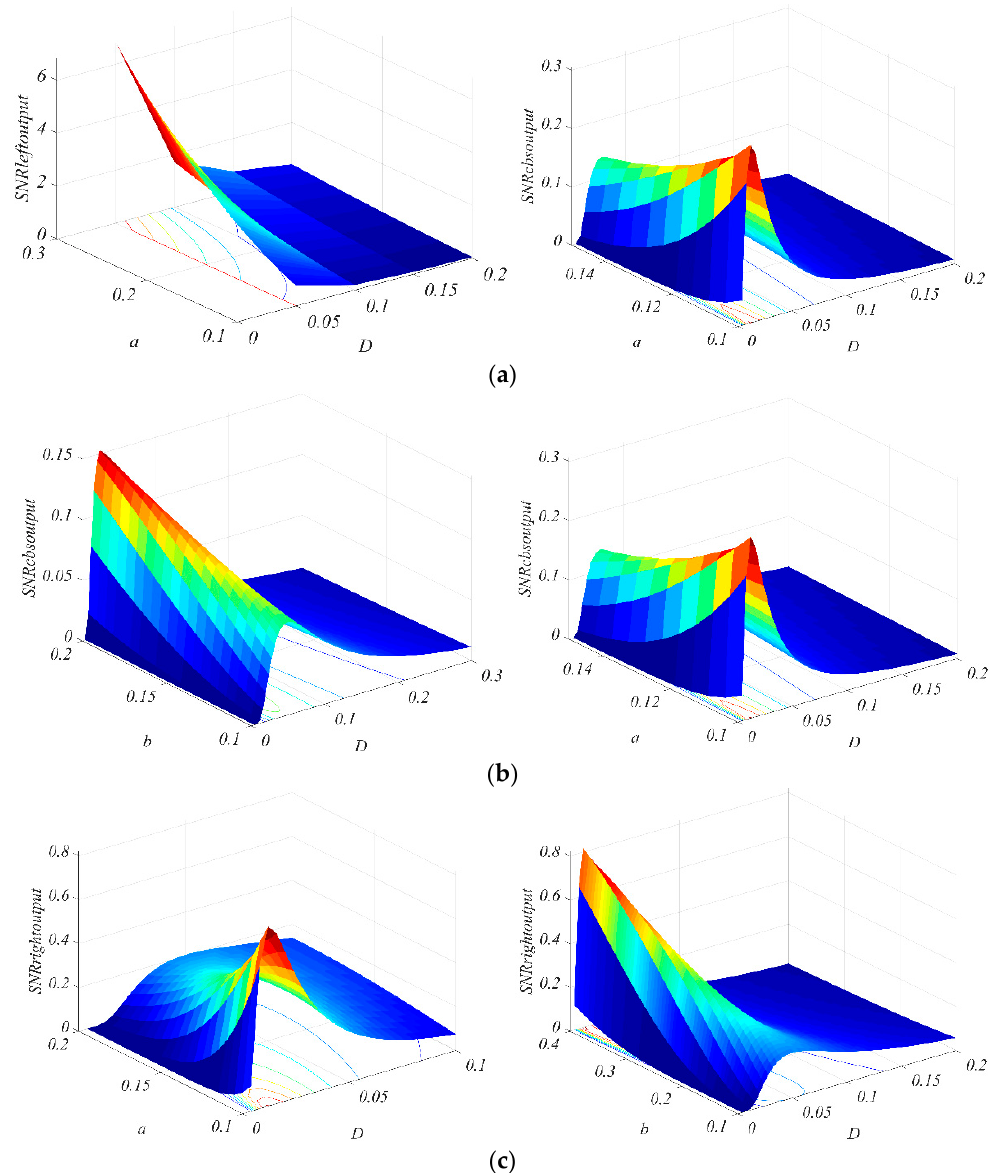
Figure 6. SNR PNABSR changes with parameter a , b , and D . ( a ) The signal-to-noise ratio output of the left well:, b = 0.1, a = 0.1; ( b ) the signal-to-noise ratio output of the middle well: b = 0.1, a = 0.1; and ( c ) the signal-to-noise ratio output of the right well: b = 0.1, a = 0.1.